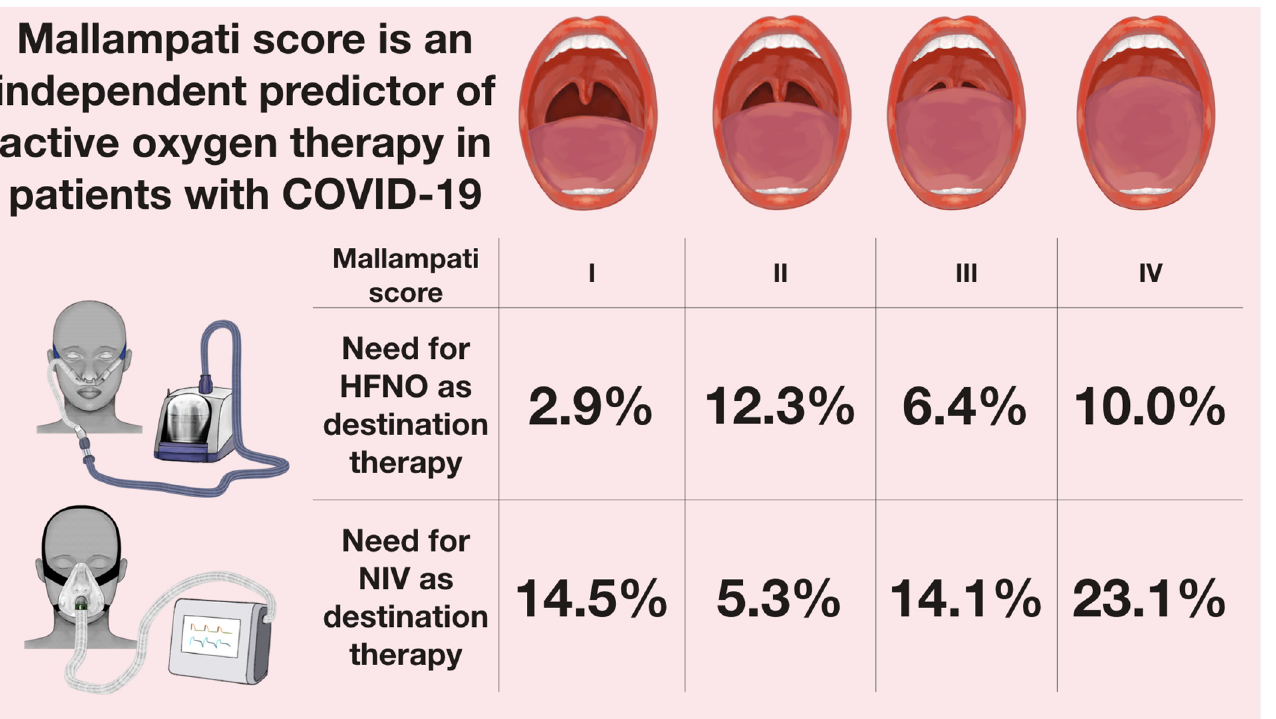
Figure 1. The percentage of patients with COVID-19 who required active oxygen therapy depending on the Mallampati score. Abbreviations: HFNO—high-flow nasal oxygen therapy; NIV—non-invasive ventilation.